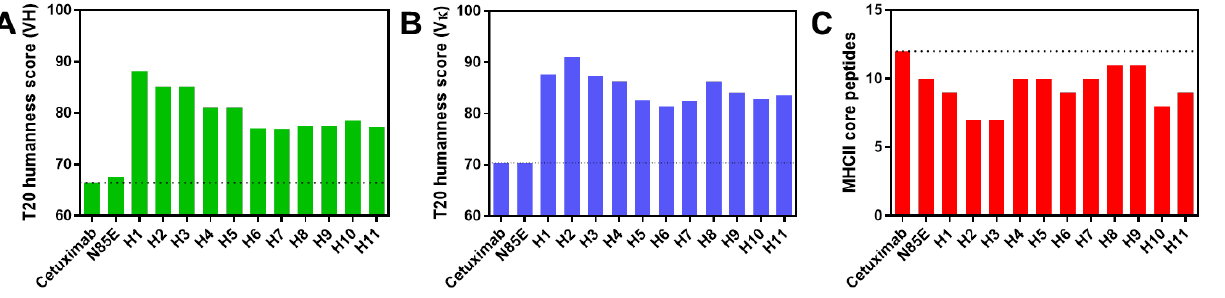
Figure 1. Properties of cetuximab sequences. ( A ) T20 humanness scores for cetuximab-derived VH sequences. ( B ) T20 humanness scores for cetuximab-derived V κ domains. ( C ) Predicted number of MHCII-binding peptides in cetuximab-derived variable regions based on the MixMHC2pred algorithm. N85E is aglycosylated cetuximab, and H1 through H11 are humanized variants.